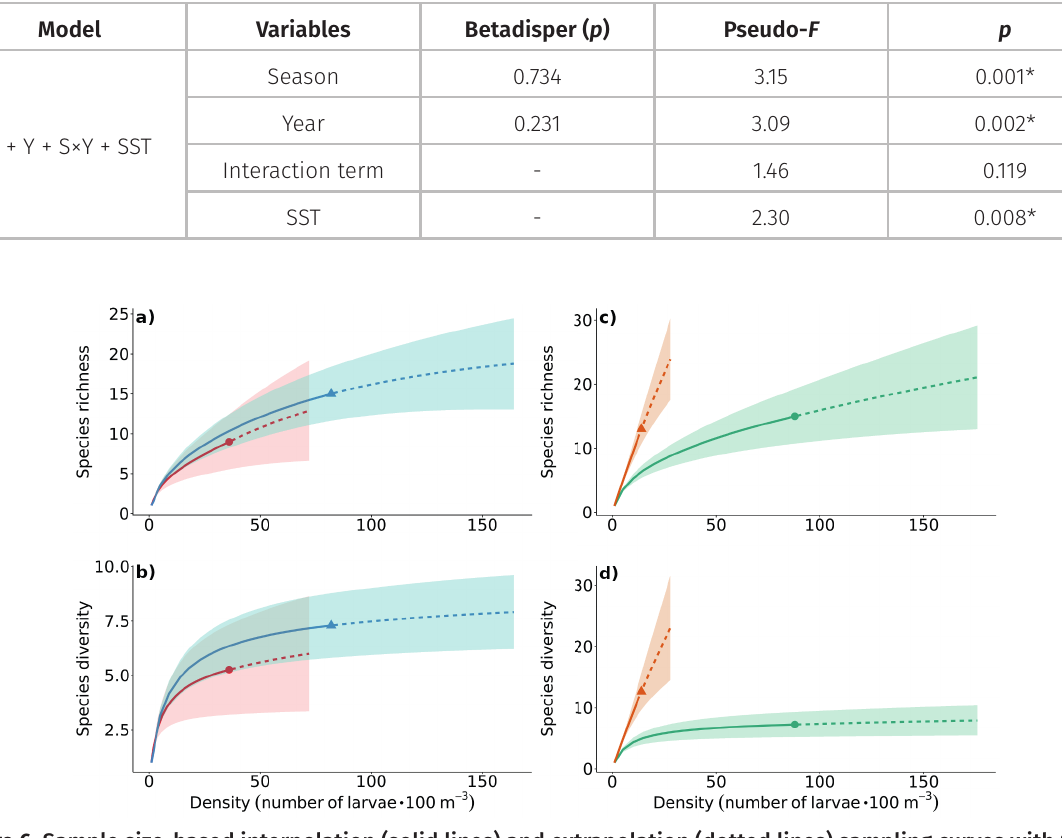
Figure 6. Sample size-based interpolation (solid lines) and extrapolation (dotted lines) sampling curves with 95% confi dence bands (shaded areas) for the seasons (plots a and b) and years (plots c and d) separately, for species richness and Shannon diversity index. The solid symbols represent the index values associated to the overall density sampled at each season or year. Spring: October to December (circles and red lines), summer: January to March (triangles and light-blue lines). Year 1: October 2011 to March 2012 (circles and green lines) and Year 2: October 2012 to March 2013 (triangles and orange lines).